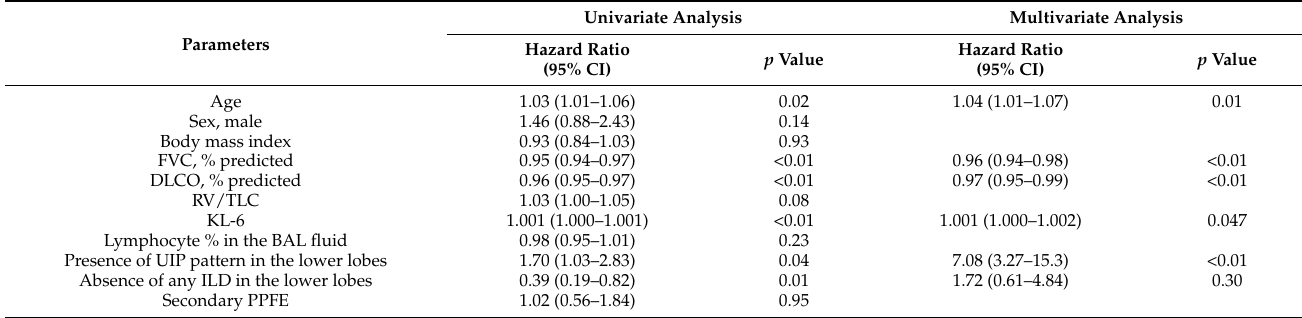
Table 5. Cox proportional hazards model assessment of potential predictors of mortality in PPFE patients with the entire